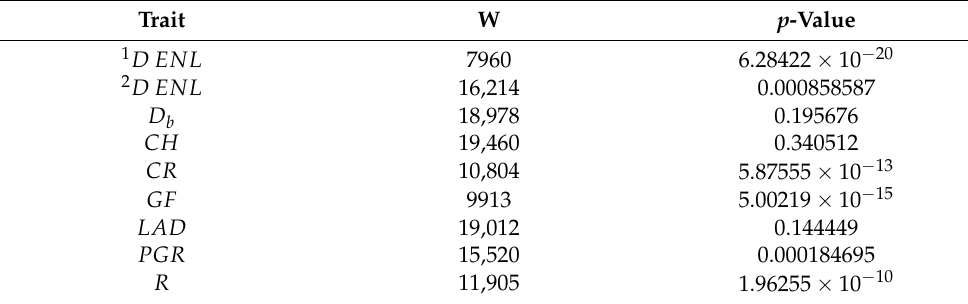
Table A16. Overview of Wilcoxon Test Results at 5m Grid Size.